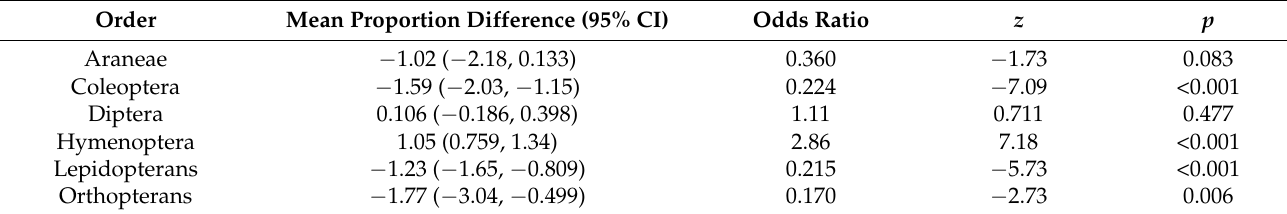
Figure 3. Mean proportion of insect orders captured in Location 1 (sites with remnant vegetation, white bars), and Location 2 (residential sites, gray bars) predicted by the model. Error bars indicate the 95 % CI of the marginal means used to test for pairwise differences between sites for each insect order (Table S3, Figure S1). Significance of each pairwise test is represented by asterisks and letters: non-significant difference (NS), significant difference at α = 0.01 (**), significant difference at α = 0.001 (***). All p -values were adjusted for multiple comparisons using Tukey’s honestly significant difference (HSD) method. See Table 1 for details of the results of the statistical comparison. Table 1. Statistical comparison of the mean proportion of insect captures for the remnant native locations (Location 1) and residential location (Location 2) by order (H0 = urban residential—urban remnant = 0) and odds ratio for each comparison. p -values were adjusted for multiple comparisons using Tukey’s honestly significant difference (HSD) method.